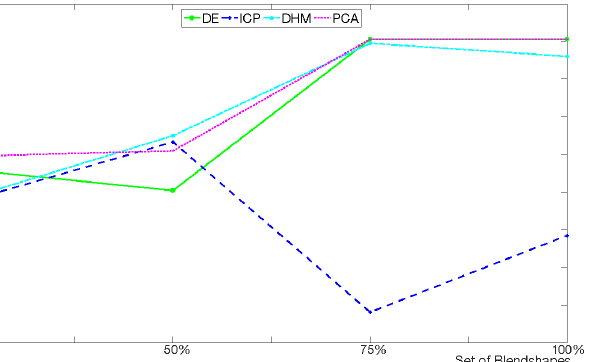
Fig. 11. Visualization of the performance of the algorithms according to the amount of blendshapes